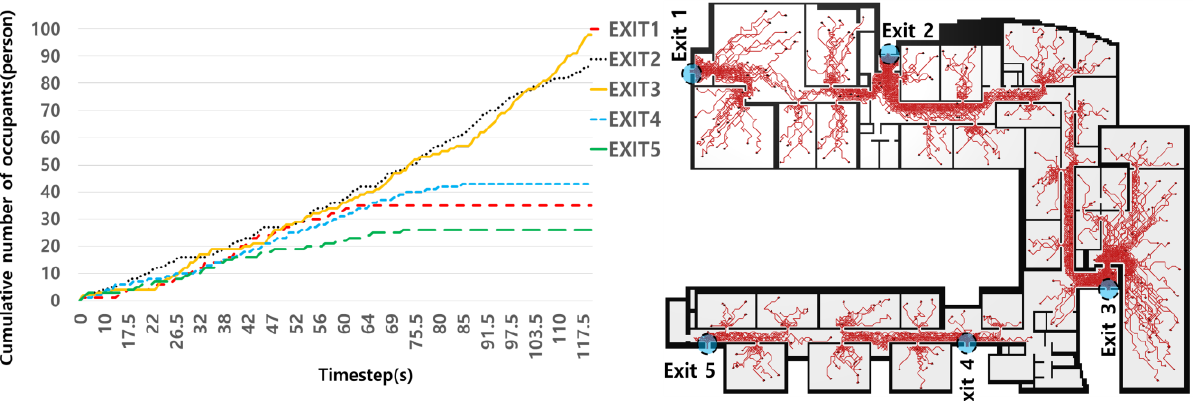
Figure 13. Situation 1: Evacuation without a